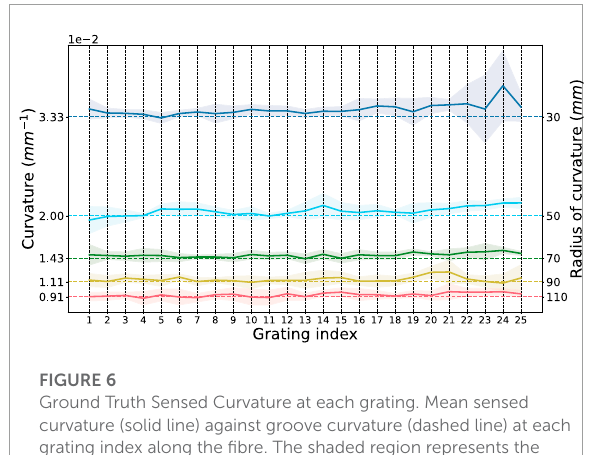
FIGURE 6 Ground Truth Sensed Curvature at each grating. Mean sensed curvature (solid line) against groove curvature (dashed line) at each grating index along the fibre. The shaded region represents the standard deviation over five iterations of